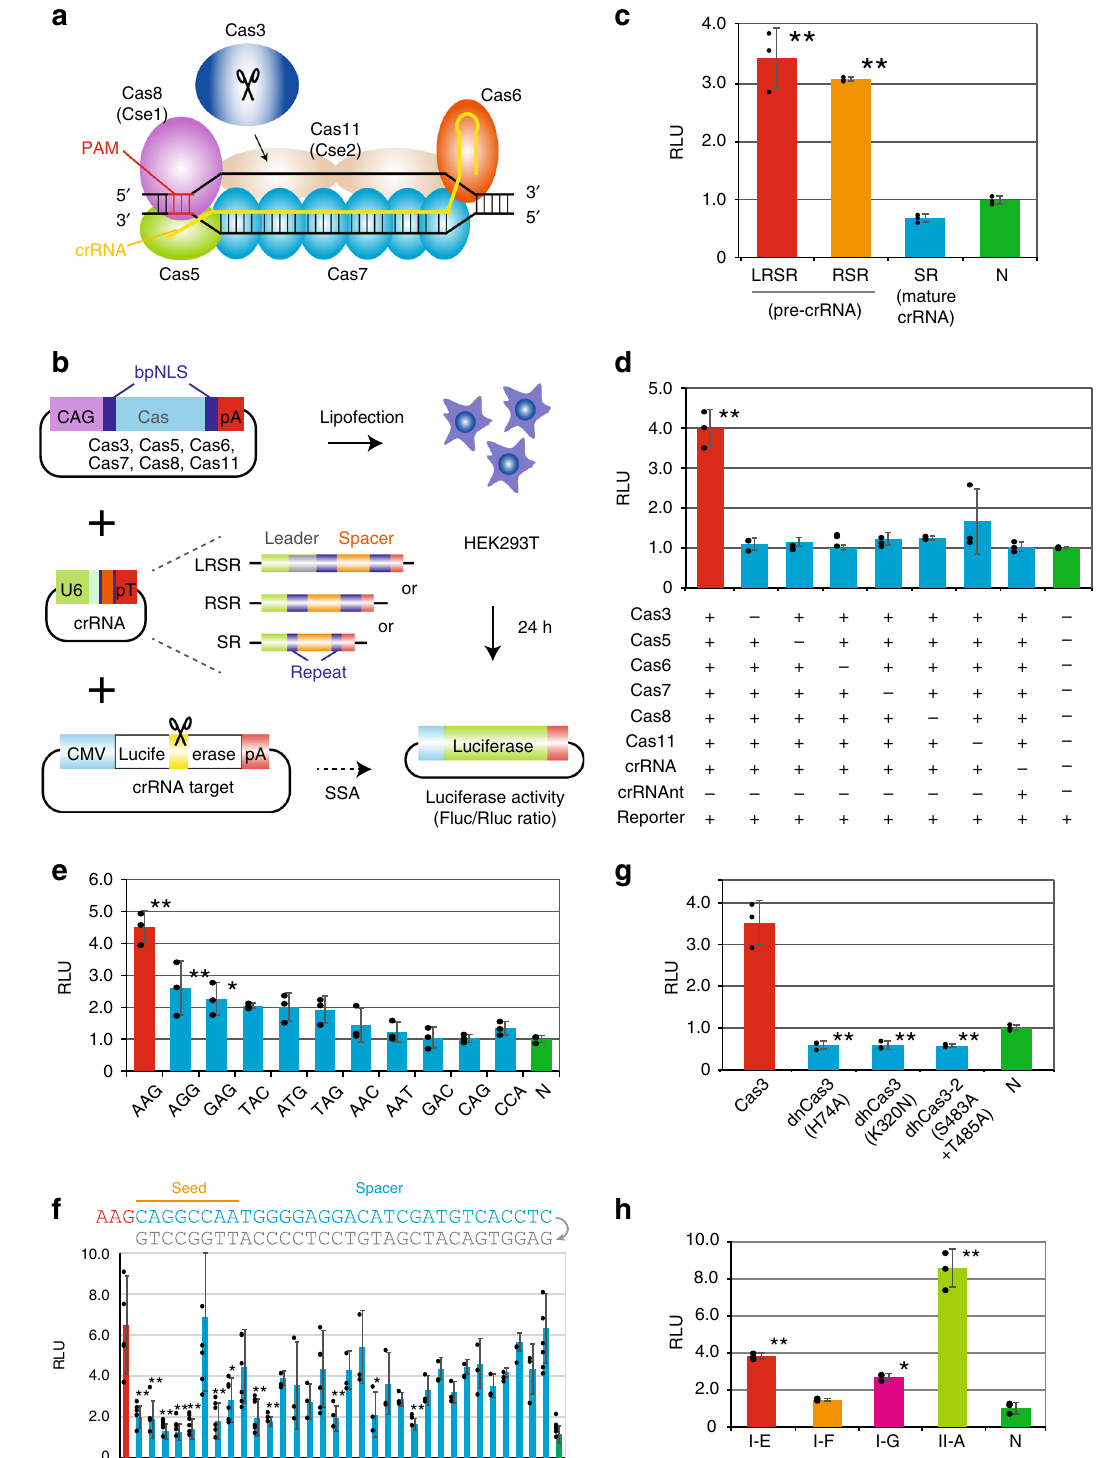
CRISPR-Cas3 mediates a broad pattern of DNA degradation . Results from the SSA assays using the type I-E CRISPR system enabled us to assess targeting for endogenous genes in human cells. We selected crRNA target sites for the EMX1 and CCR5 genes (Fig. 2a and Supplementary Fig. 5a). Lipofection of pre- crRNA and six Cas (3, 5 – 8, and 11)-coding plasmids into 293T cells resulted in a broad pattern of Cas3-mediated DNA